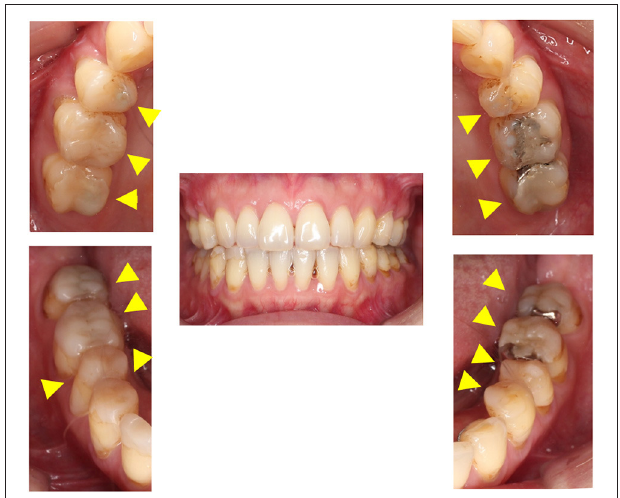
FIGURE 2 | Intraoral pictures at the first visit in case 2. All teeth contacted but the dental composite resins were constructed on almost all her lower teeth for the occlusal adjustment following orthodontic